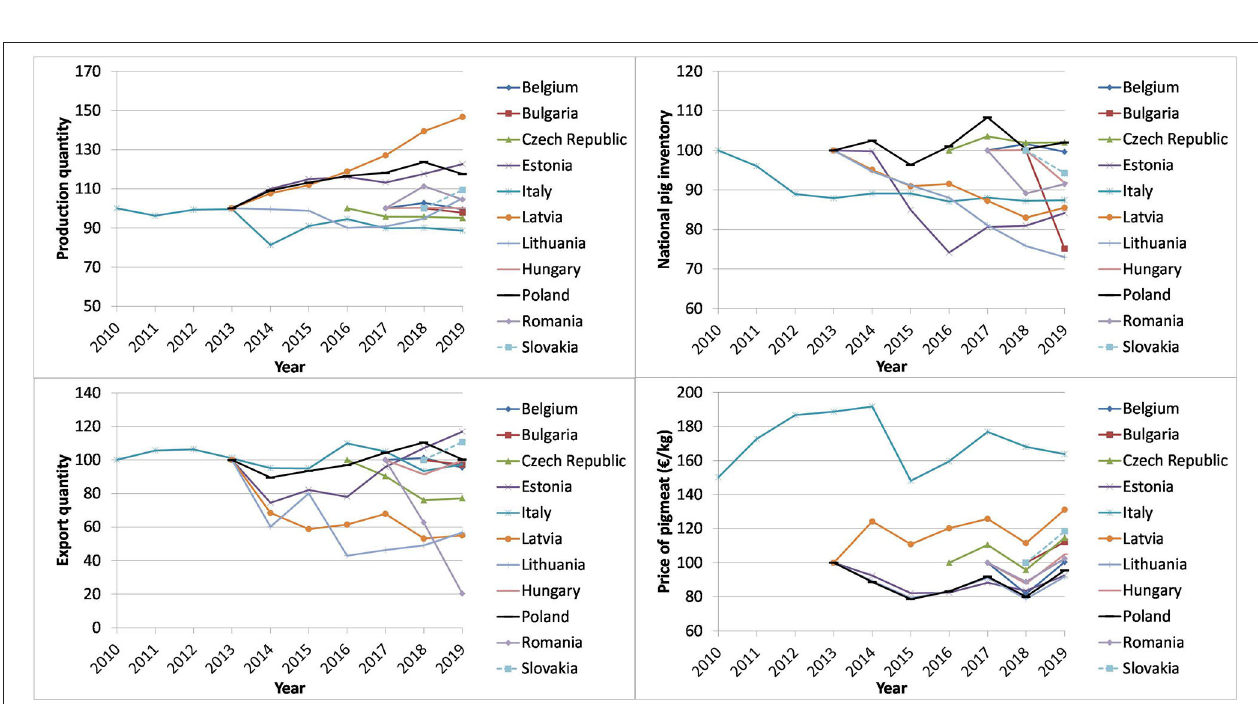
FIGURE 1 | The evolution of the quantity of pigmeat produced, the national pig inventory, the quantity of exported pigmeat (2010 = 100), and the price of pigmeat (class E, e /kg) in the study countries and in Germany and Denmark. Romania was not included in the export graph because of visualization reasons. Sources: Eurostat, the European Commission.